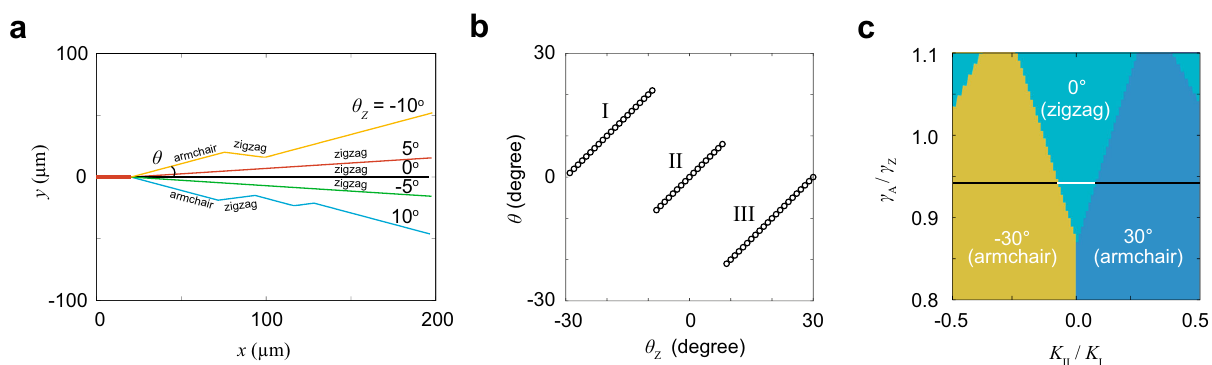
Fig. 4 Fracture behaviors of a pre-crack-containing sample under mode-I loading ( K II = 0), where the pre-crack aligns with the zigzag direction. a Crack paths predicted for different values of θ Z with R = 0.94. b The fi rst crack de fl ection θ in panel a at x = 20 μ m. The results show that the angle θ − θ – III, which are spaced by 30 ∘ . c The next-preferred edge cleavage after the fi rst de fl ection, plotted as a Z is a constant in each of the three regions I function of R and K II / K I at the crack tip. The conditions corresponding to crack advancing along the zigzag direction and without kinks in panel ( a ) are annotated as the white segment of the solid line plotted for R =